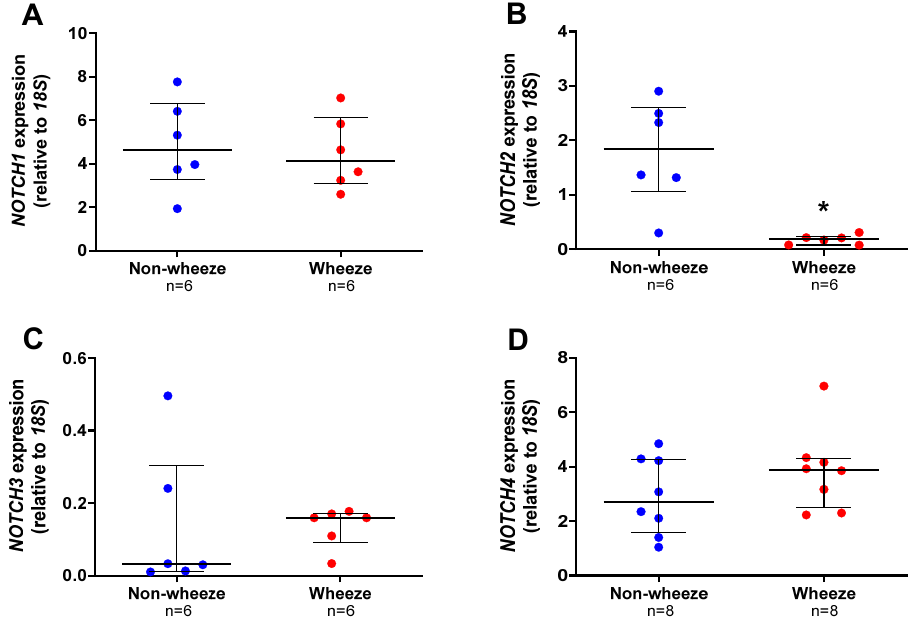
Figure 2. Notch receptors gene expression profiles in ex vivo pAEC from children with and without wheeze. Relative expression of NOTCH1–4 receptors ( A – D ) were measured in ex vivo pAEC from children with and without wheeze ( n ≥ 6) by real-time qPCR (refer to 2.5.4). ( A ) NOTCH1 was the most abundantly expressed Notch receptor gene in ex vivo pAEC from a paediatric cohort. However, NOTCH1 mRNA expression was not significantly different between pAEC from children without wheeze. ( B ) In contrast, mRNA expression of NOTCH2 was significantly lower in pAEC from children with wheeze compared to their non-wheeze counterparts. ( C , D ) Finally, no significant differences were observed between pAEC from children with and without wheeze in mRNA expression of NOTCH3 and NOTCH4, although the genes were expressed at different magnitudes. Each dot represents the mean of two replicates from a single ex vivo sample. Data are normalized to housekeeping gene, 18S and represented as median ± IQR. * Statistical significance relative to the non-wheeze cohort ( p < 0.050; Mann–Whitney